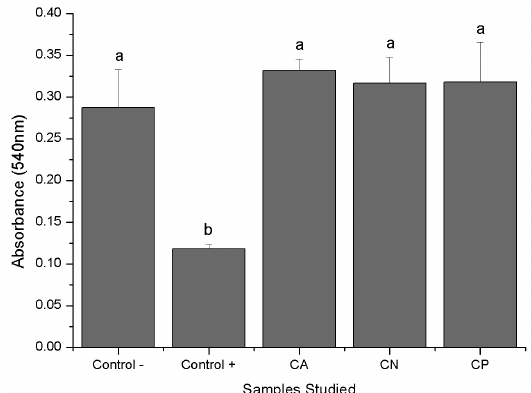
Figure 3. Indirect cytotoxicity test for chitosan substrates. We do not found any indirect toxic effect of CA, CP or CN. Different letters indicate significantly different means ( p < 0.05).